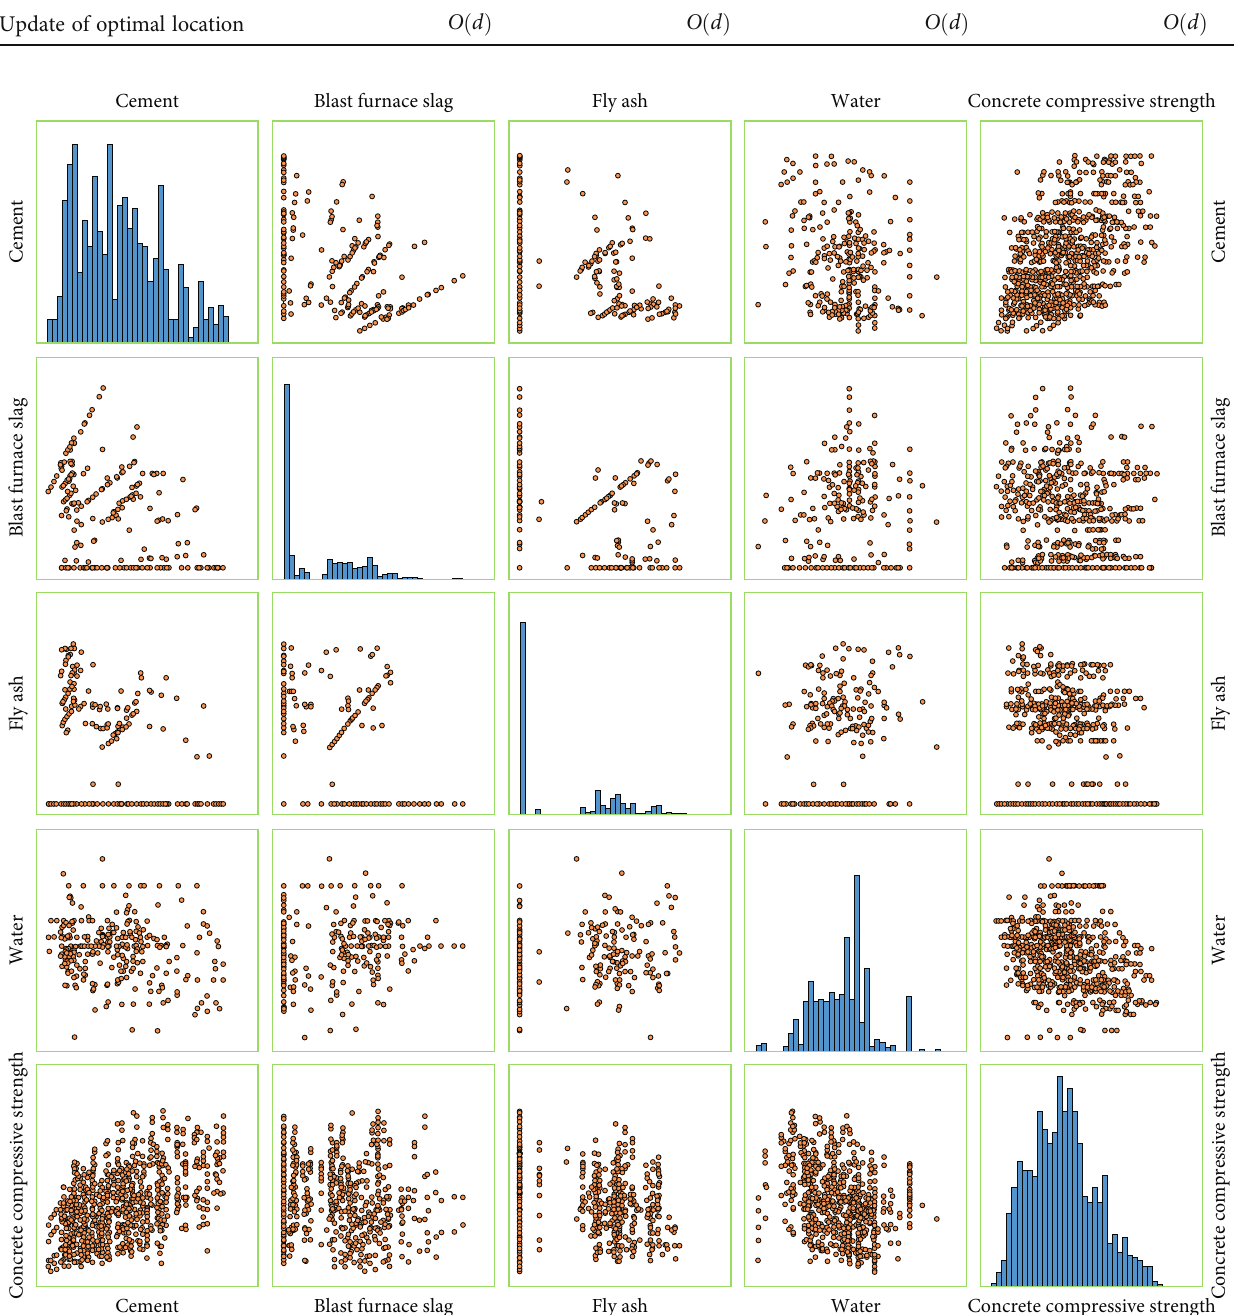
Figure 9: Plot of the relationship between output variables and the fi rst 4 input feature variables (cement, blast furnace slag, fl y ash, and